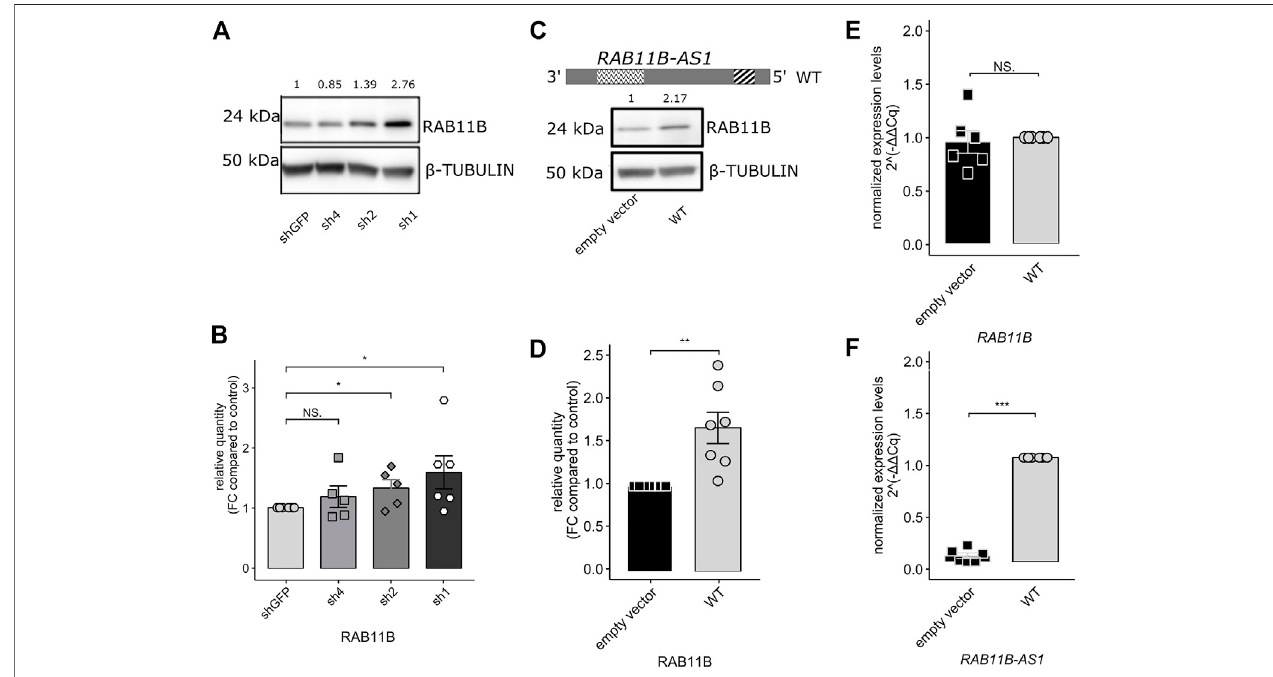
FIGURE 3 | RAB11B-AS1 (WT) over-expression leads to RAB11B protein stabilization without affecting its mRNA levels. (A) Representative Western Blot shows RAB11B levels increase in CHD8 KD lines (sh4, sh2, sh1). β -TUBULIN was used as loading control. (B) The barplot reports the densitometric analysis of WB experiments. RAB11B protein levels increase in CHD8 KD lines (signi fi cance in sh2 and sh1 lines). Data are plotted as Mean ± SEM. For statistical analysis, un-paired one-tailed Student ’ s t -test was performed. N (cid:1) 5 – 6. NS p > 0.05, * p ≤ 0.05. (C) The RAB11B-AS1 (WT) sequence schematic reports the location of the putative SINEUP domains (up) . Representative Western Blot image (down) depicts RAB11B protein increase upon RAB11B-AS1 (WT) over-expression in GM8330-8 hiNPC line. β -TUBULIN was used asloading control. (D) Barplot ofRAB11B densitometric analysis, con fi rming that protein increase was statistically signi fi cant upon antisense lncRNA over-expression. (E) The barplot reports RAB11B transcriptional levels, tested by qPCR analysis and expressed as 2 − ΔΔ Cq . mRNA levels were stable upon RAB11B-AS1 over-expression (black) with respect to the control empty vector (white). (F) RAB11B-AS1 was abundantly and signi fi cantly overexpressed upon plasmid construct delivery (black) with respect to the control (white). Data are plotted as Mean ± SEM of N (cid:1) 6 biological replicates. For statistical analysis, un-paired one-tailed Student ’ s t -test was performed. Sample size N (cid:1) 6. NS p > 0.05, ** p ≤ 0.01, *** p ≤